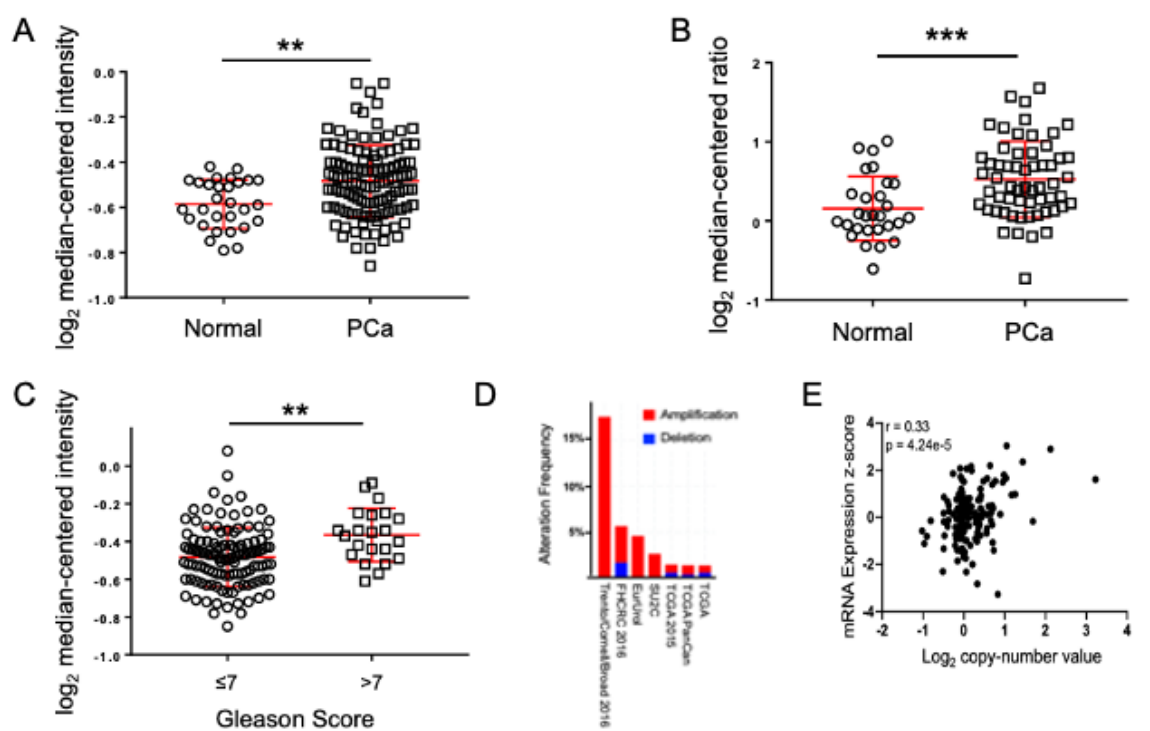
Figure 2. Magmas is overexpressed in human prostate cancer. ( A , B ) Meta-analysis showing Magmas mRNA overexpression in prostate tumor samples compared to normal tissues from expression arrays [16,20] using the Oncomine database. ** p < 0.001, *** p < 0.0001 (Unpaired two-tailed t test).